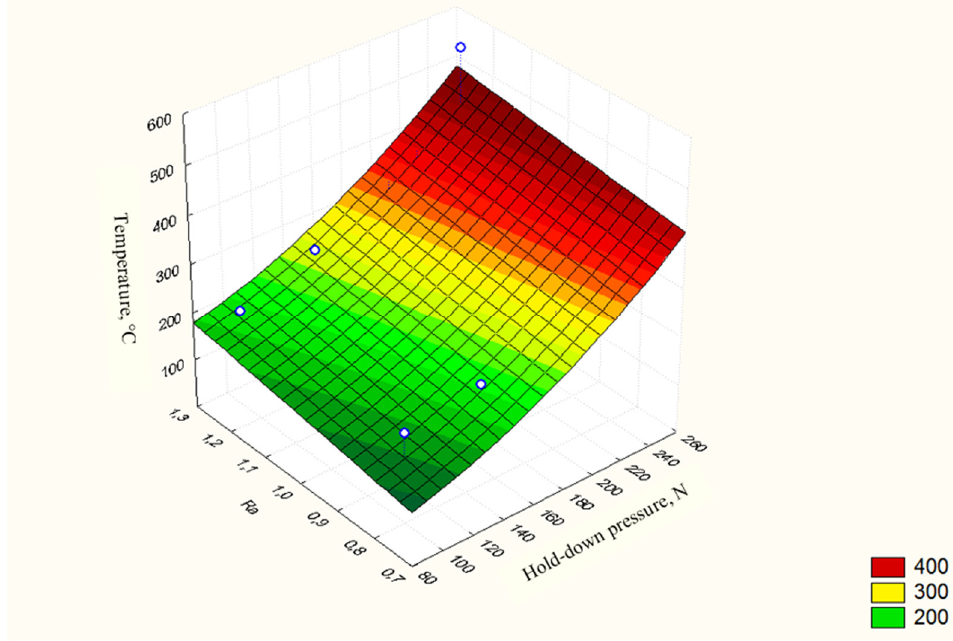
Figure 5. Dependence of the temperature in the burnishing zone on the tool clamping force and the initial surface roughness for dry burnishing.